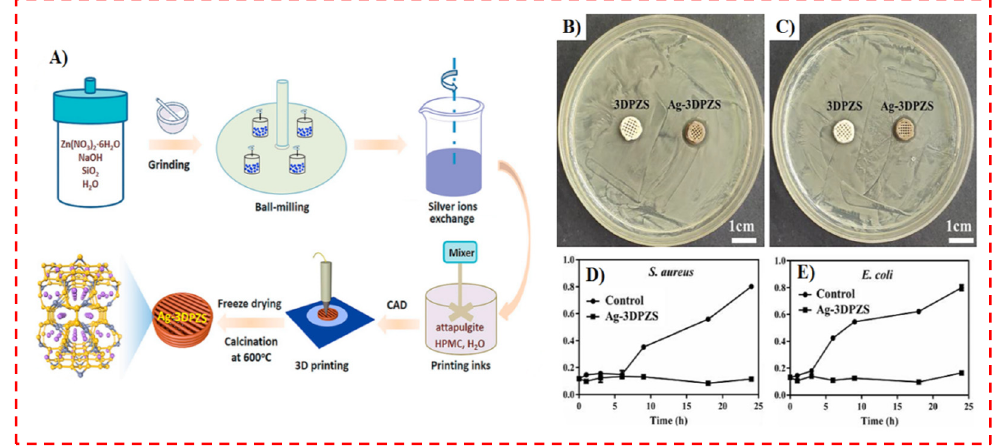
Figure 11. ( A ) Schematic illustration of overall fabrication process of Ag-3DPZS via 3D printing and representative photographs of the bacterial inhabitation zone (IZ) created by the different scaffolds against S. aureus ( B ) and E. coli ( C ); bacterial growth kinetics in liquid medium: S. aureus ( D ) and E. coli ( E ) [131].